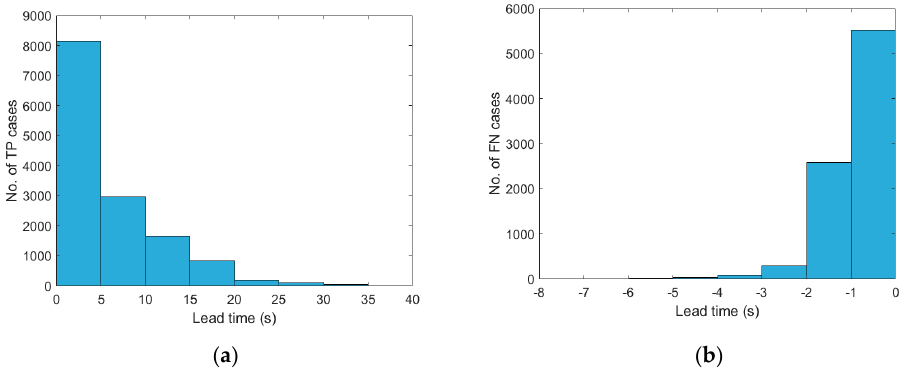
Figure 4. The distribution of the ( a ) TP cases; and ( b ) FN cases at different lead time ranges. (LG Stylus).